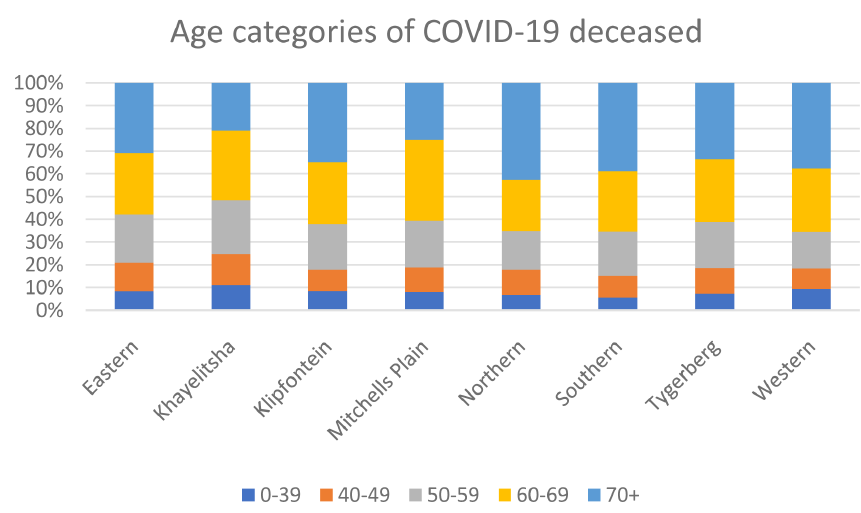
Figure 5. Age categories for the deceased COVID-19 patients, by sub-district.